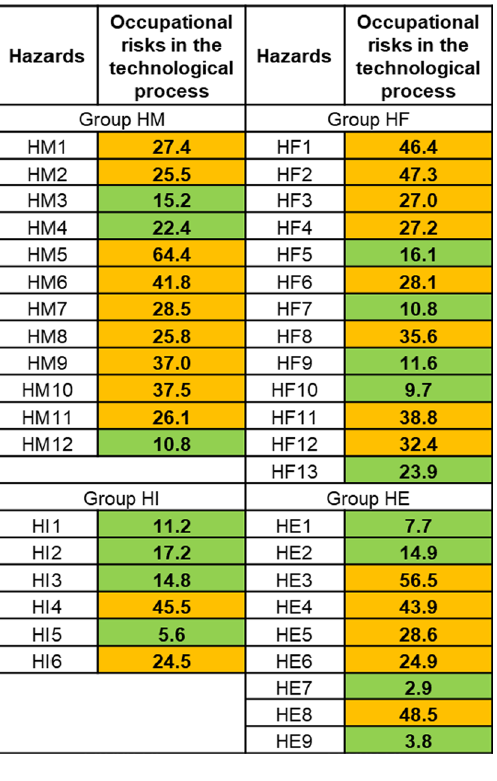
Fig. 7 The results of the occupational risk assessment for the techno- logical process